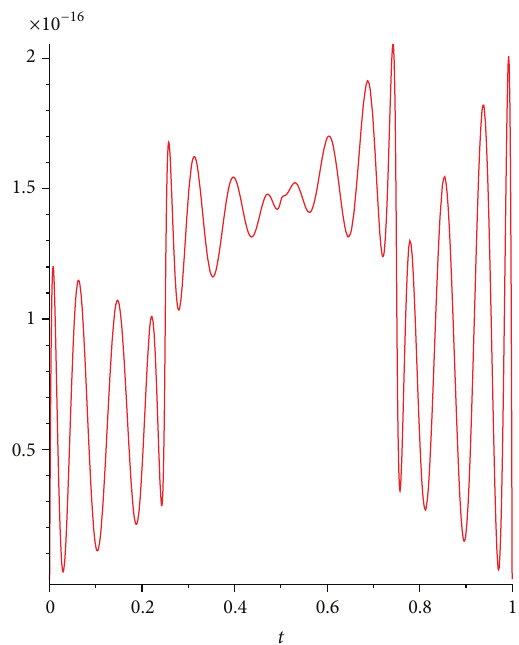
Figure 1: The graph of absolute errors for Example 4 for 𝐾 = 4 , and 𝑀 = 9